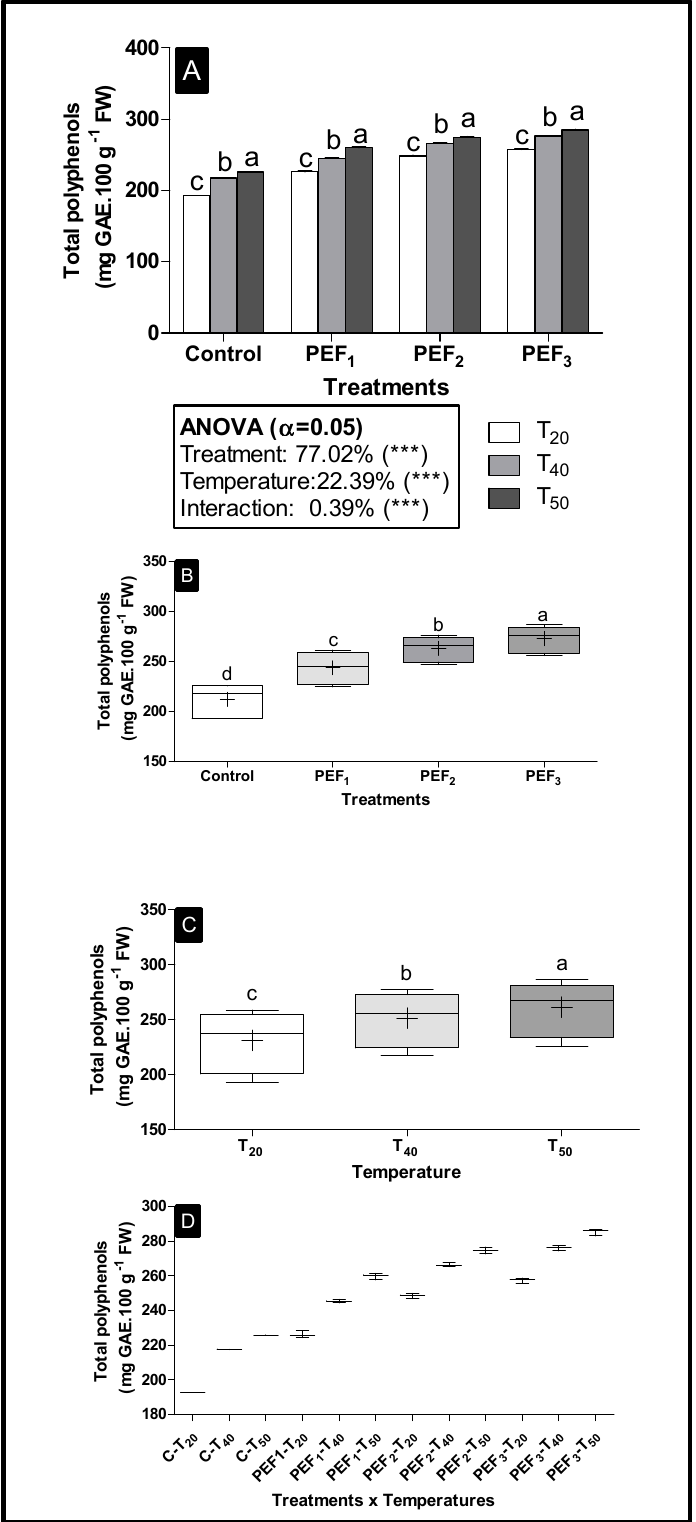
Figure 5. Concentrations of total polyphenolics content for the extracts obtained with untreated and PEF-treated methods at 20 °C, 40 °C, and 50 °C. The tests were performed as triplicates and values are mean ± standard deviation. Different superscript alphabets in a row show significant difference ( p < 0.05) using Duncan’s multiple-range tests.